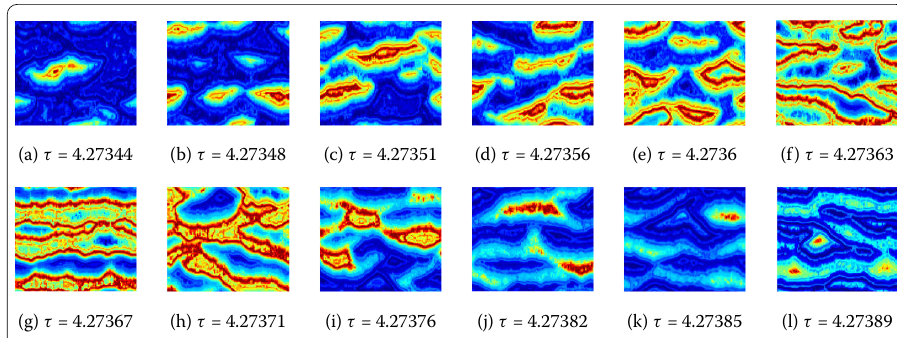
Figure 8 Pattern transition with the variation of τ covering [4.2734,4.2739]. Detailed information of the cyclic transition process in Fig. 7 is shown. The conditions for pattern simulations are exactly the same as those in